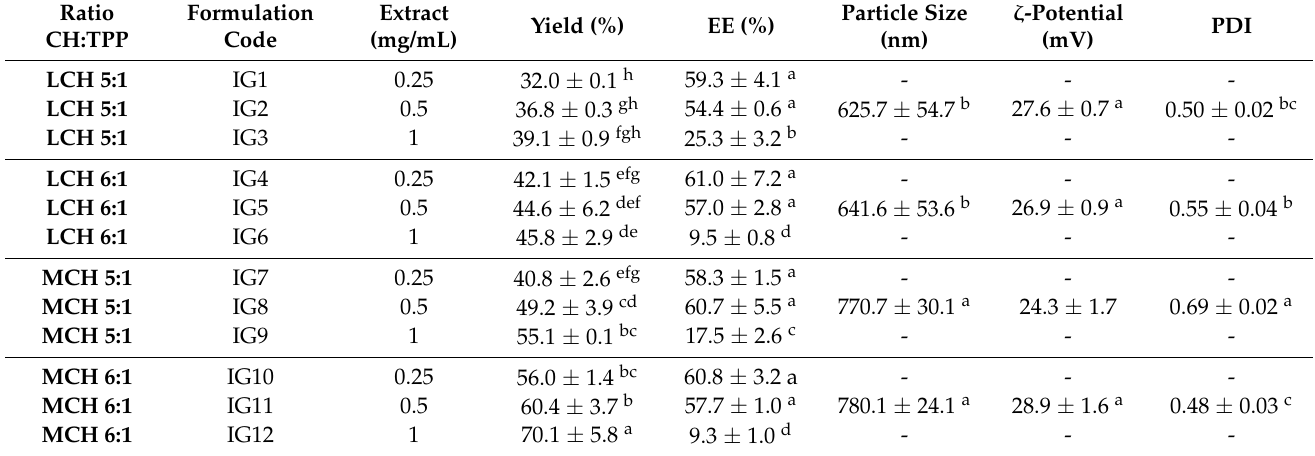
Table 2. Characterization of different formulations obtained by ionic gelation (mean ± SD, n = 3). LCH: chitosan low molecular weight; MCH: chitosan medium molecular